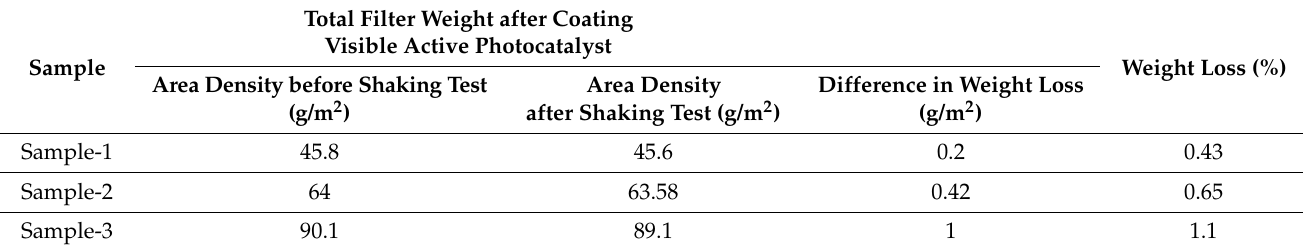
Table 1. Photocatalyst weight content on non ‐ woven polymer fabric in detachment test.